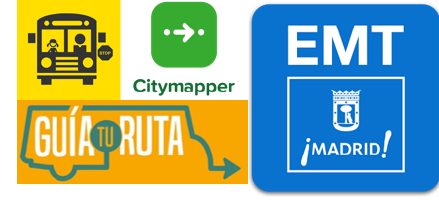
Figure 2. Smart Mobility Application